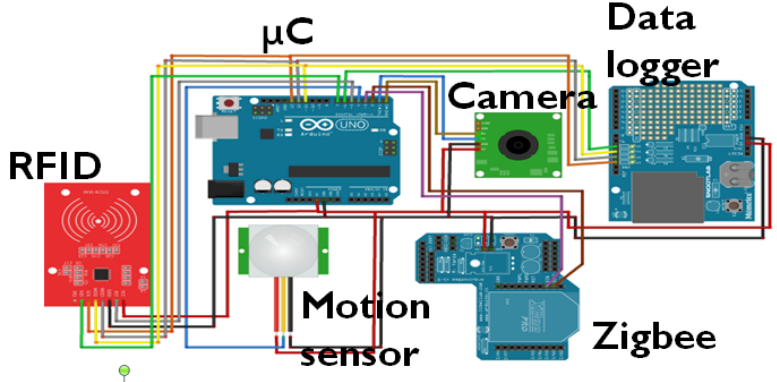
Figure 8. Greenhouse security node annotated schematic diagram.